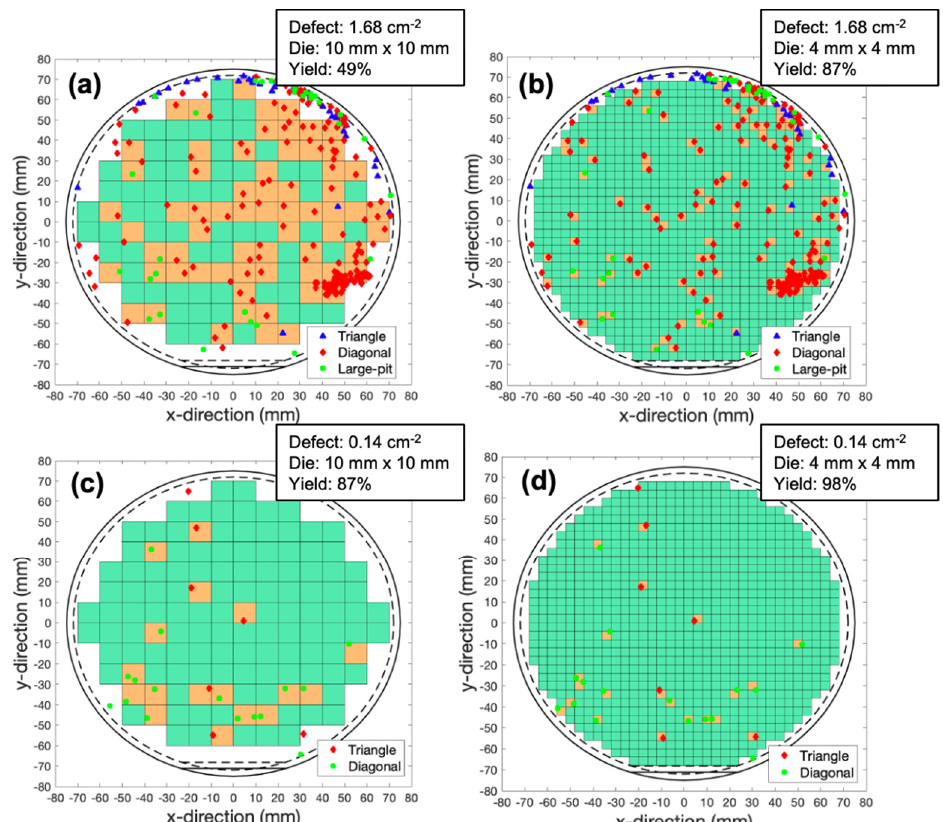
Figure 9. Schematic structure of planar and trench MOSFET [18]. The above figure is reproduced from reference [18].